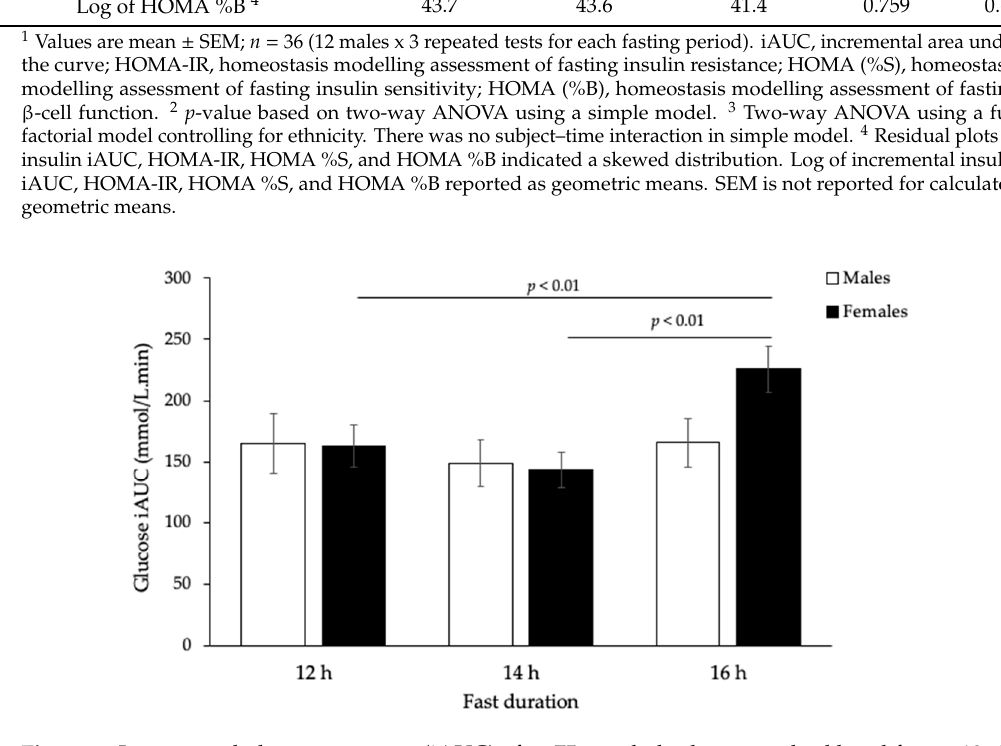
Figure 2. Incremental glucose response (iAUC) after 75 g carbohydrate standard breakfast at 12, 14, and 16 h fasting periods ( n = 24, p < 0.01, two-way ANOVA). There was also an overall significant difference in glucose iAUC between males and females over time ( p < 0.01, two-way ANOVA).